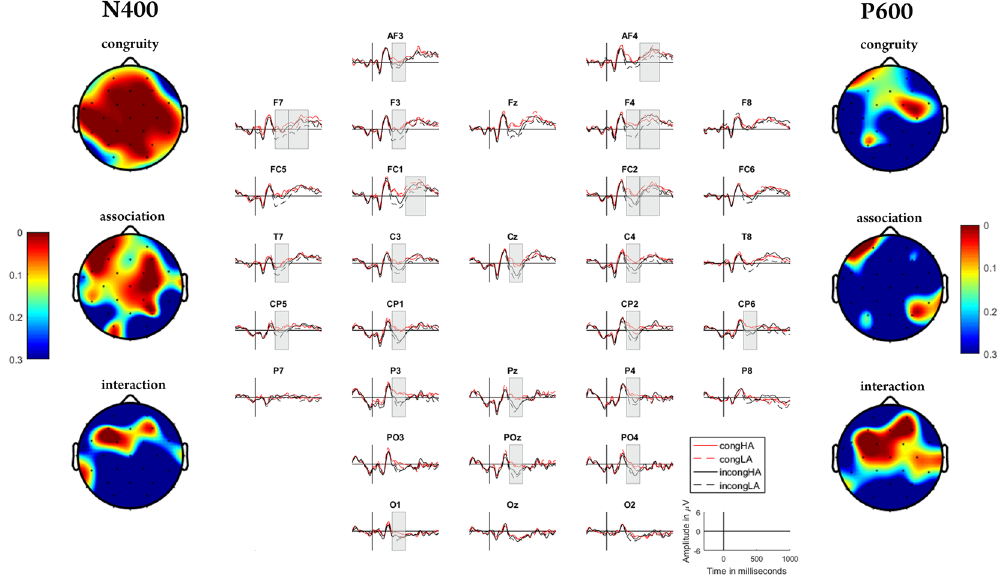
Figure 1. Grand average ERPs of all 16 subjects tested, plotted for the four studied sentence groups and the spatial distribution of the considered